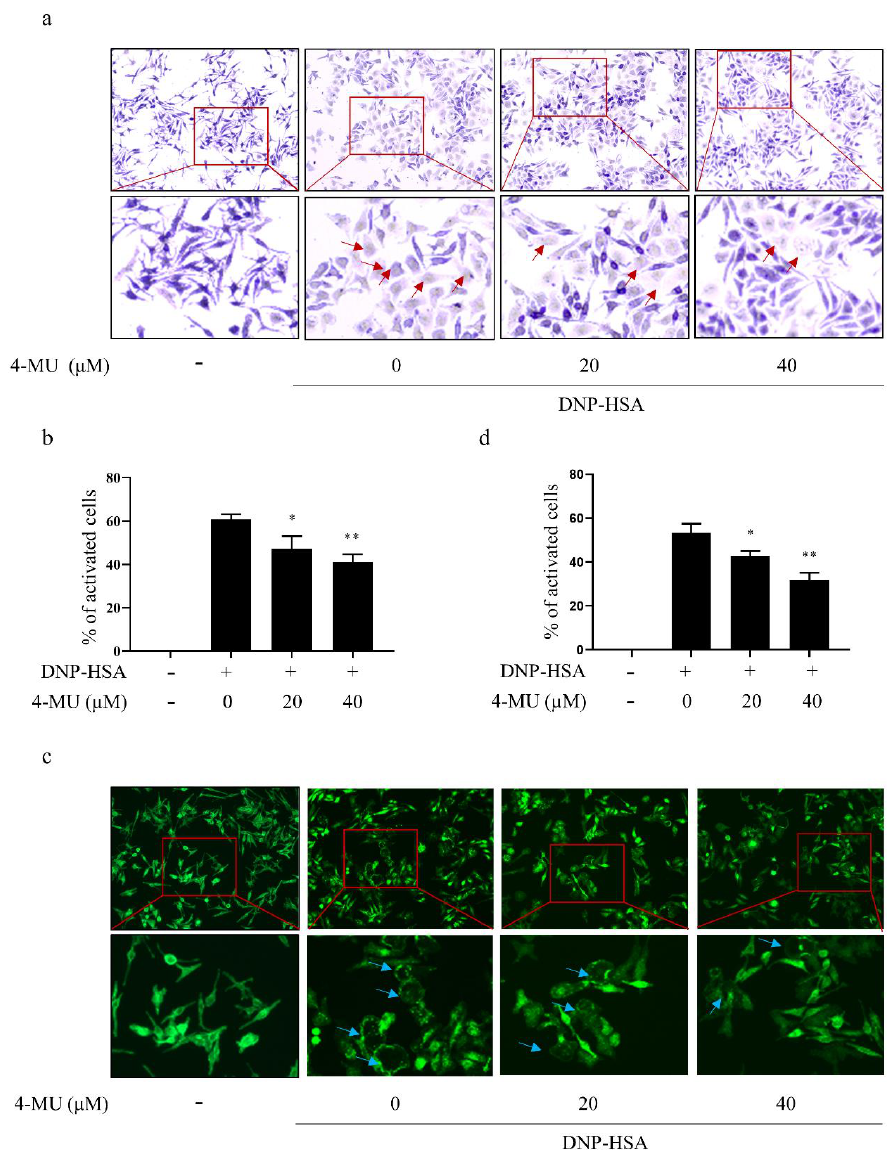
Figure 2. 4-MU suppresses FcεRI -mediated morphological changes in RBLs. Anti-DNP IgE-sensitized RBLs were pretreated (or not) with 4-MU for 1 h and then challenged with DNP-HSA (100 ng/mL) for 30 min. ( a , b ) Representative micrographs of toluidine blue-stained RBLs. Red arrows indicate irregular cell morphology and the release purple particles. ( c , d ) FITC-phalloidin stained RBLs. Blue arrow indicates cell morphology irregularity due to decomposition of F-actin cytoskeleton. Means ± SDs (of three independent experiments) are shown; * p < 0.05, ** p < 0.01 vs. activated cells without treatment. Abbreviations as in Figure